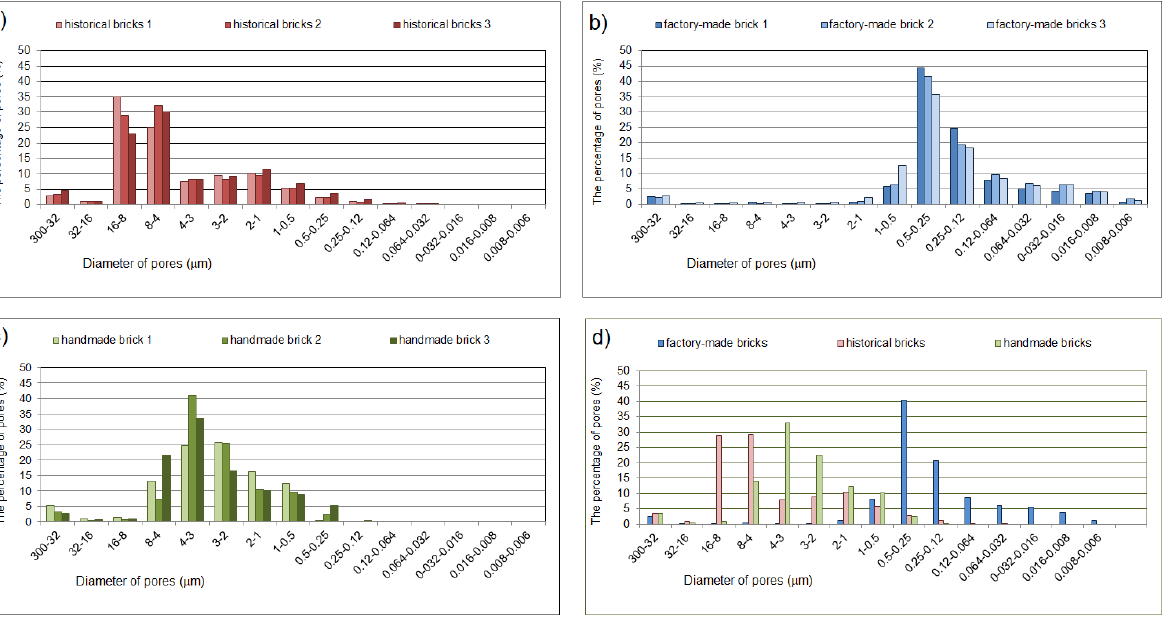
Figure 5. Distribution of pores in brick samples ( a ) historical brick, ( b ) factory-made brick, ( c ) hand-formed brick, and ( d ) a comparison of the average porosity distributions of all bricks.